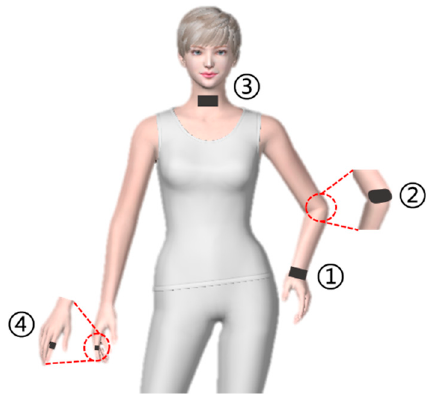
Figure 7. Different body parts for motion detection. Table 3. Horizontal and vertical sizes of different body parts.